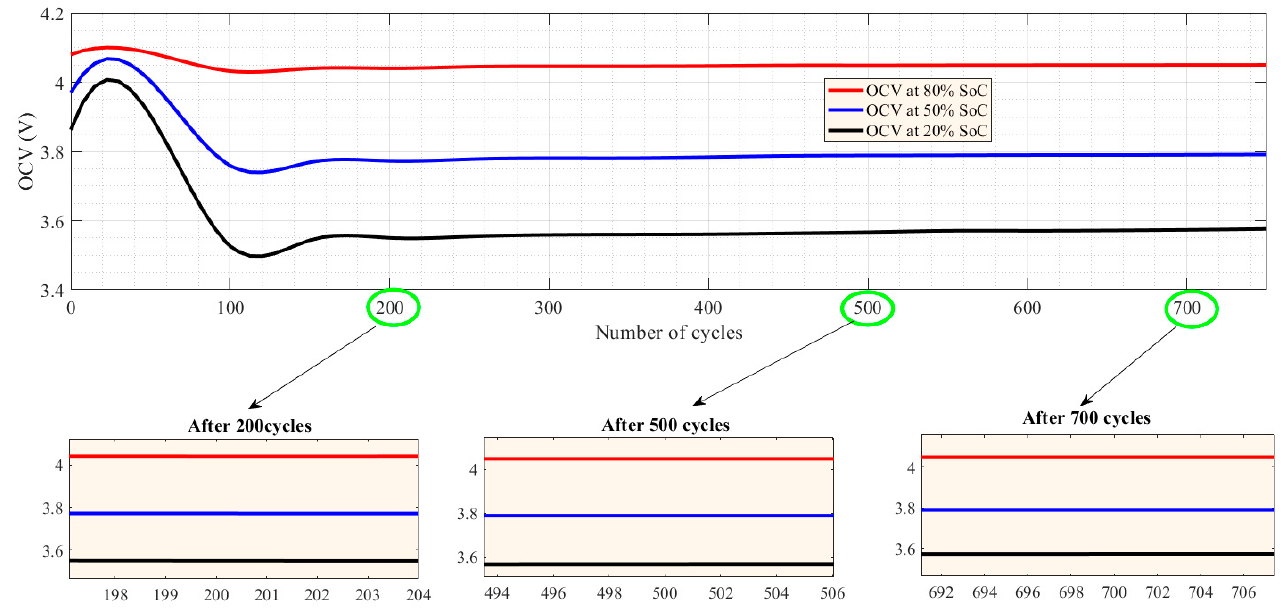
Figure 10. Comparison of the OCV pattern at 25 °C under C/2 charge and 1 C discharge test conditions.